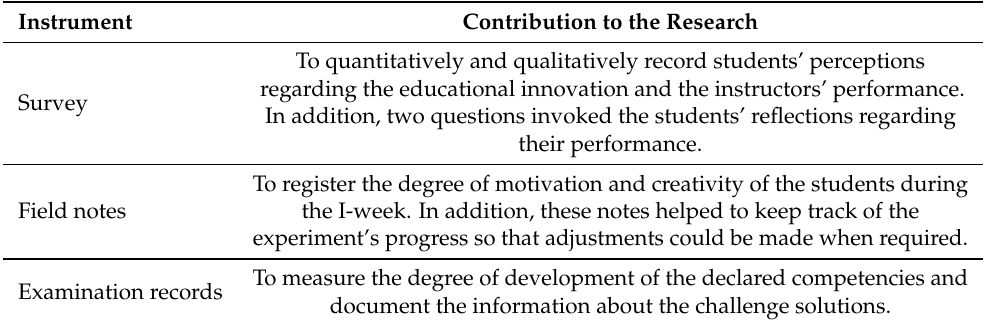
Table 2. Relation between instruments and